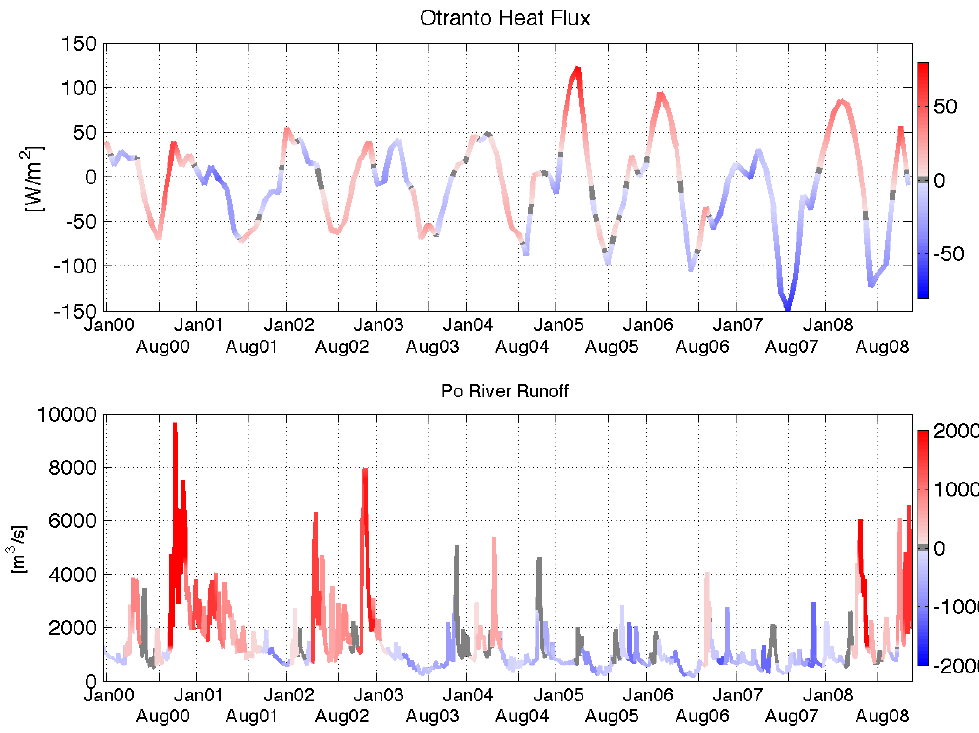
Fig. 3. Top panel: monthly time series of advective heat flux through Strait of Otranto, units are Wm − 2 and colour indicates monthly anomaly values. Bottom panel: daily time series of Po river runoff, units are m 3 s − 1 , colour indicates monthly anomaly values.